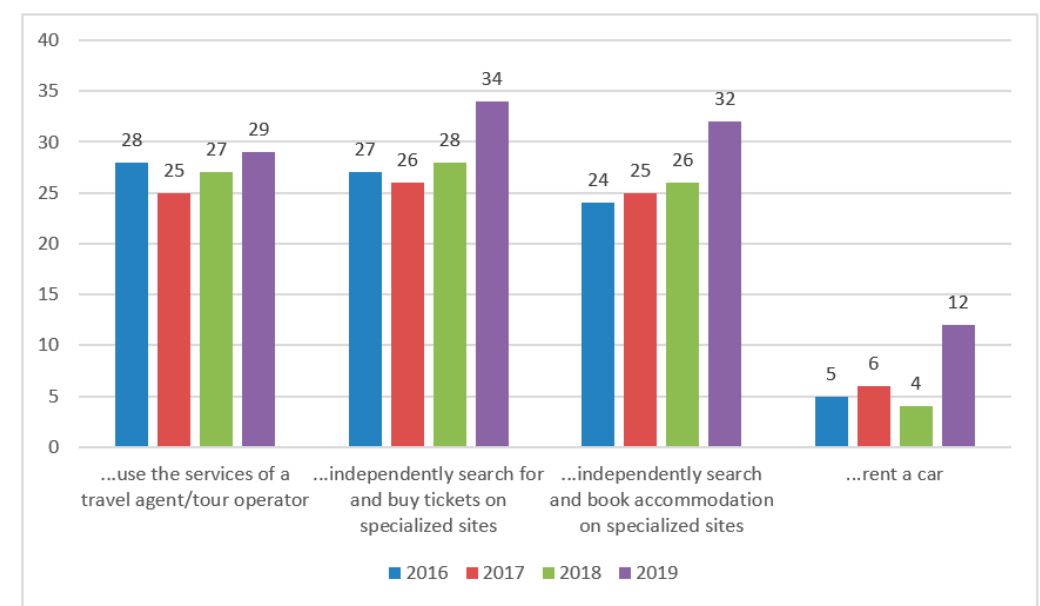
Figure 1. Respondent answers to the question, “If we talk about your upcoming vacation, how likely is it that you...”, by years (NAFI 2019).